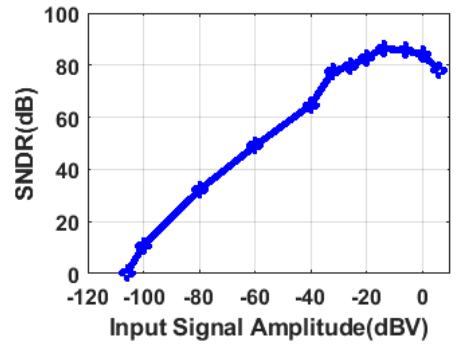
Figure 13. Signal-to-noise and distortion ratio (SNDR) versus 15 kHz input signal amplitude.